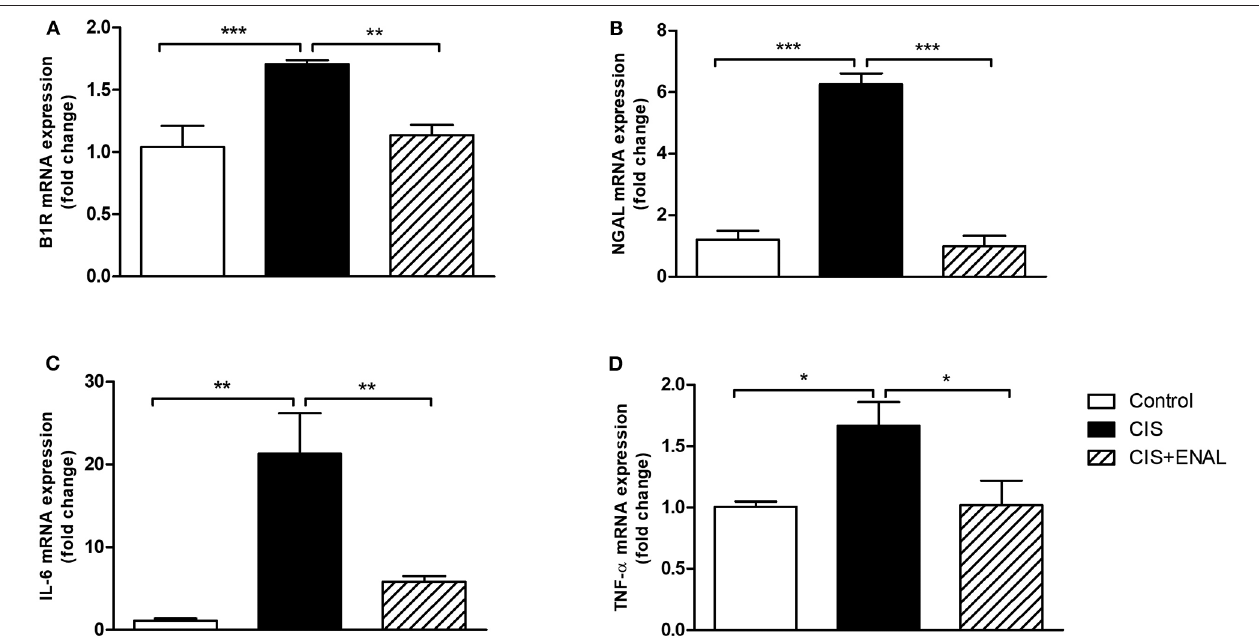
FIGURE 5 | Mouse epithelial tubular cells mRNA expression. The panels show mouse tubular cell mRNA expression of (A) B1R, (B) NGAL, (C) IL-6, and (D) TNF- α after treatment with cisplatin and cisplatin + enalaprilat. Data presented as Mean ± SEM; * p < 0.05, ** p < 0.01, *** p < 0.001.